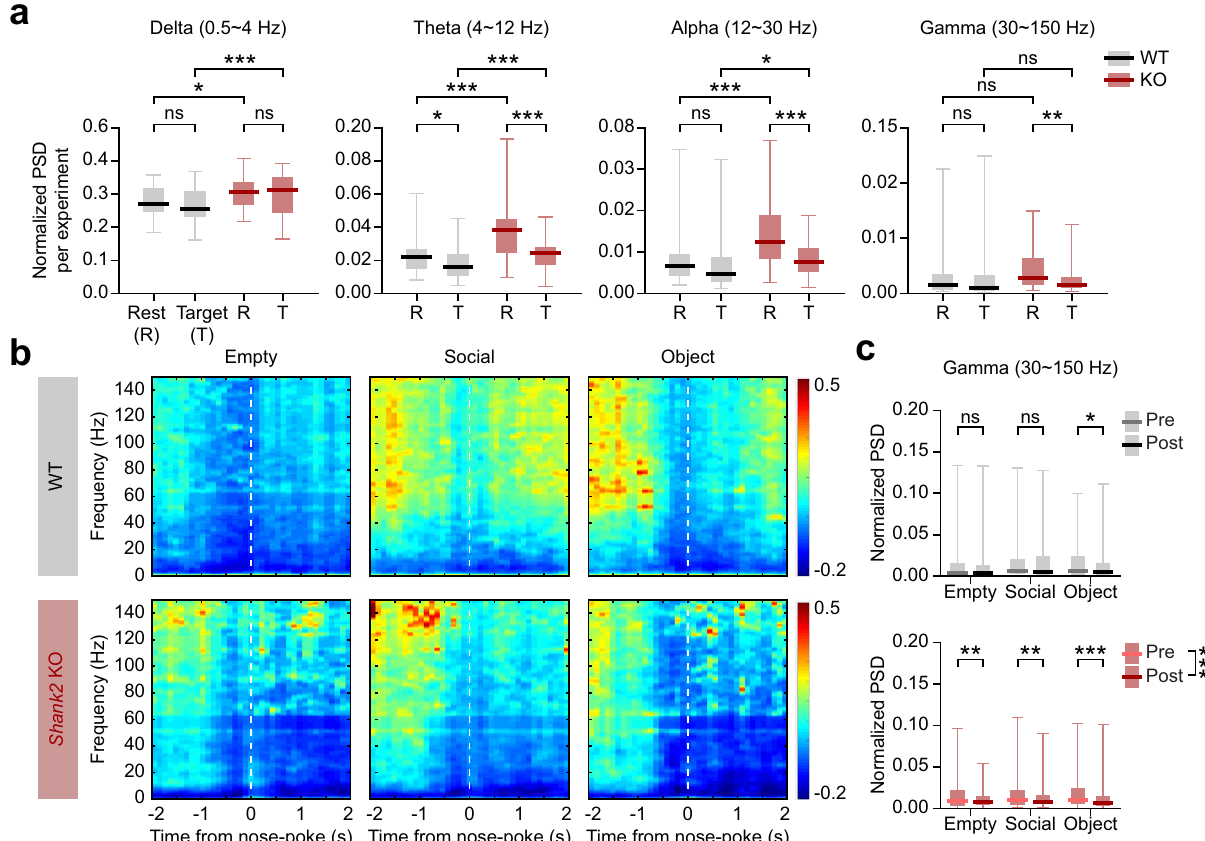
Fig. 3 Enhanced resting-state, but suppressed target-induced, oscillations in the Shank2 – / – mPFC. a Enhanced resting-state, but suppressed target (S/ O/E combined)-induced, oscillations in the Shank2 – / – mPFC compared with WT mice. Local fi eld potentials (LFPs) measured during rest periods and the entire period of S/O/E target exploration were used for the analysis ( n = 53 experiments from 5 WT mice, and 52 experiments from 5 KO mice, * p < 0.05, ** p < 0.01, *** p < 0.001, ns, not signi fi cant, two-way ANOVA with Tukey ’ s test; genotype p < 0.001, event p = 0.153, interaction p = 0.712 [delta], rest p = 0.014, target WT-KO p < 0.001 [WT-KO-delta], WT p > 0.05, KO p > 0.05 [rest-target-delta], genotype p < 0.001, event p < 0.001, interaction p